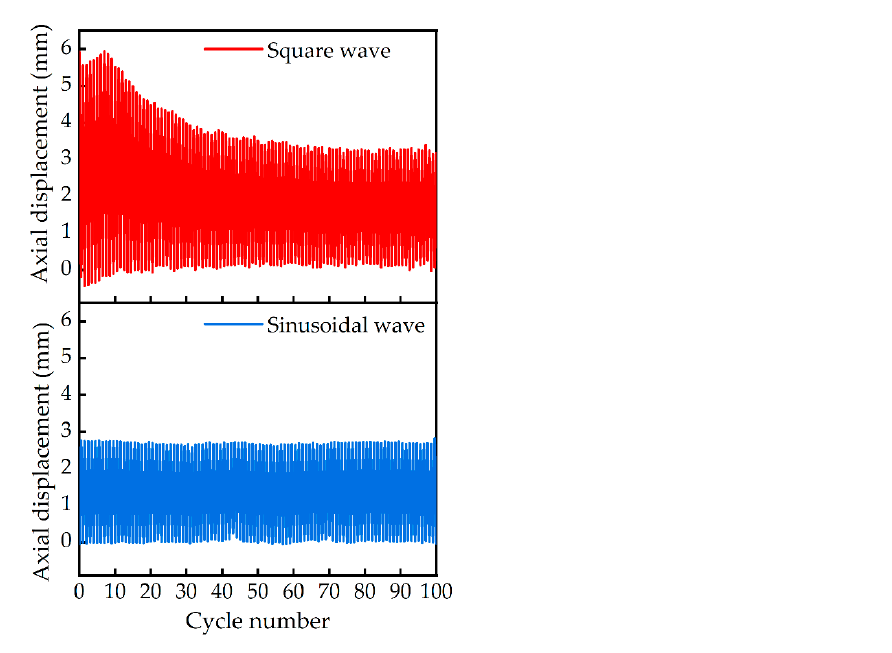
Figure A1. The axial displacements of the helical IPMC actuator within 100 cycles under the input signal of 3 V, 0.1 Hz.